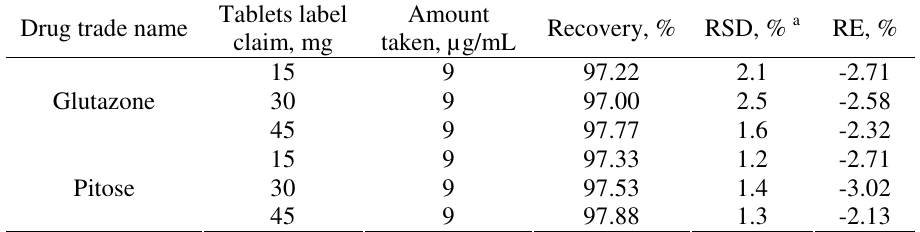
Table 2. Determination of pioglitazone in different tablet dosage form using developed